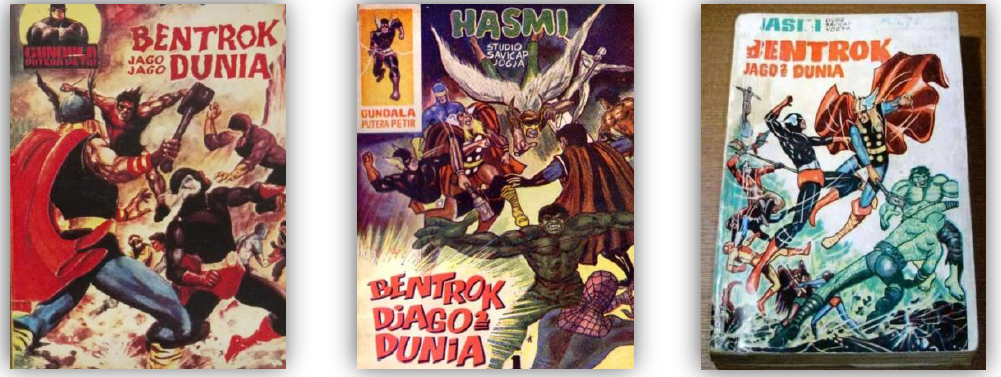
Figure 1: The depiction of a crossover between Indonesian superheroes and American superheroes in the 1970s in some of the Gundala Putera Petir comics by